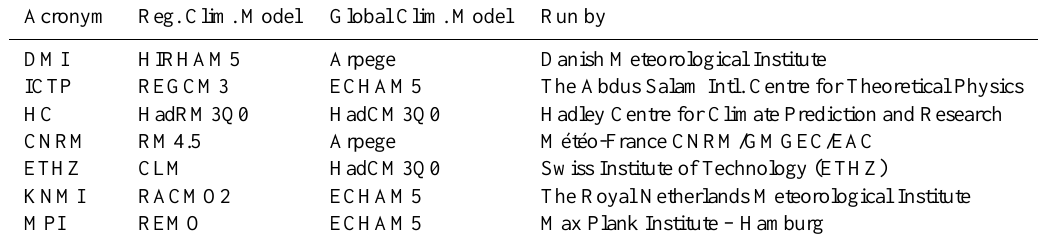
Fig. 2 the Optimal Interpolation map